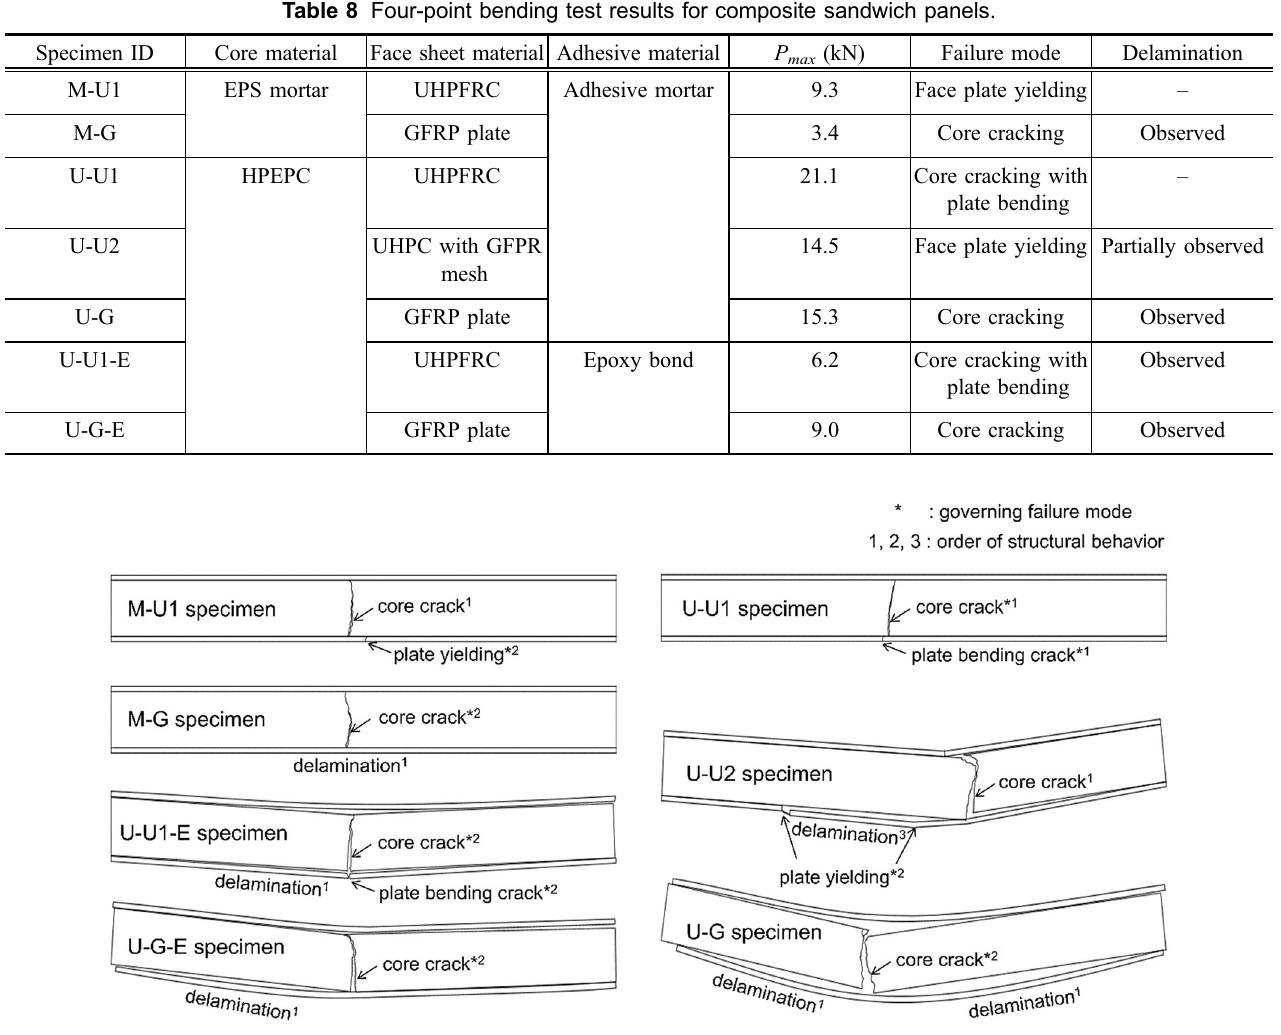
Fig. 10 Flexural test results of composite sandwich panels.